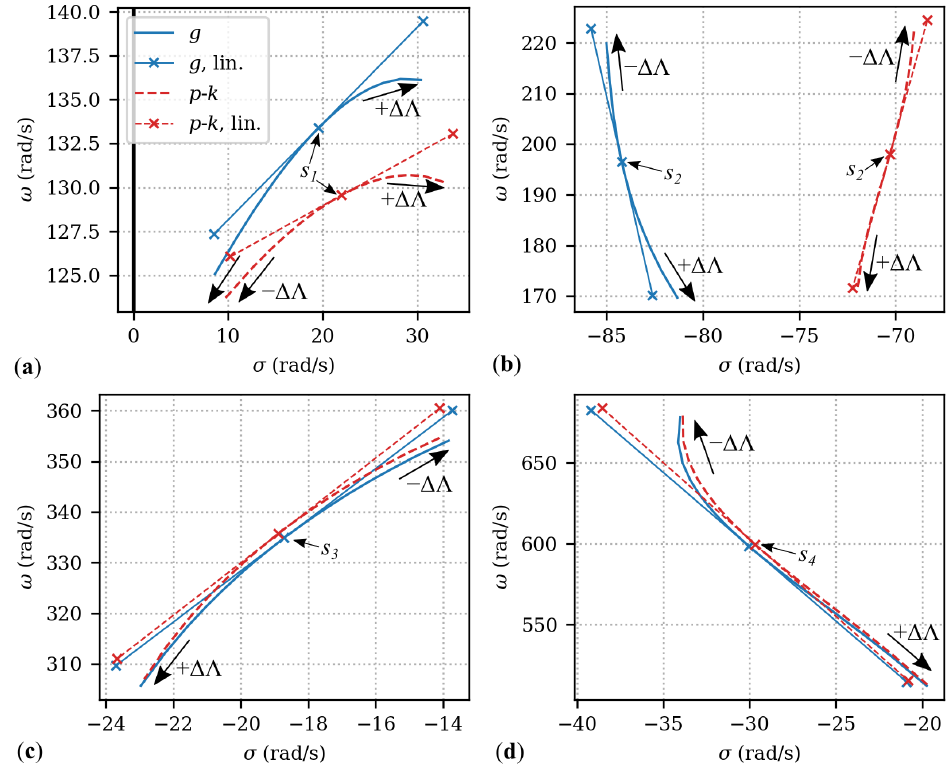
Figure 9. Eigenvalue solutions for the AGARD 445.6 weakened model employing the p - k method and the g method at V = 230.7 m/s for changing sweep angle Λ displayed in the complex plane. The eigenvalue derivatives obtained at ∆Λ = 5.9 × 10 − 5 ◦ and scaled by ∆Λ max are depicted as tangent lines at the unchanged eigenvalue solution (center ×). ( a ) First eigenvalues s 1 . ( b ) Second eigenvalues s 2 . ( c ) Third eigenvalues s 3 . ( d ) Fourth eigenvalues s 4